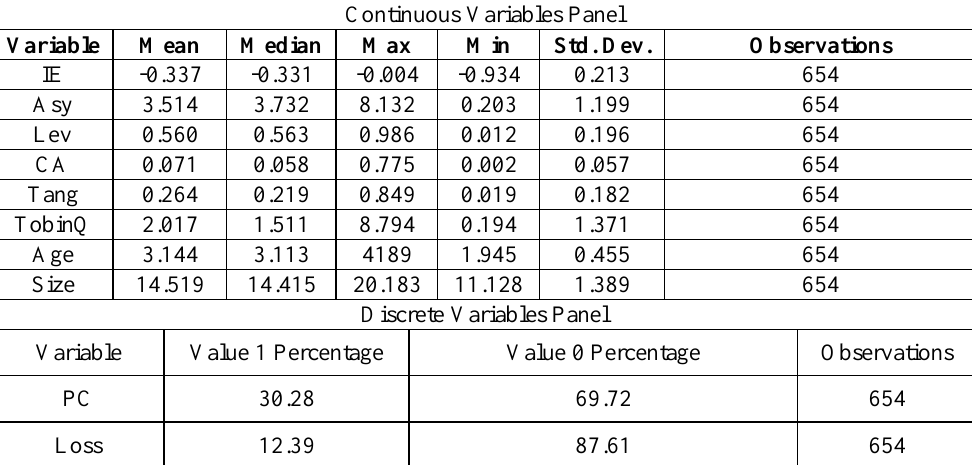
Table 2. Descriptive statistics of research